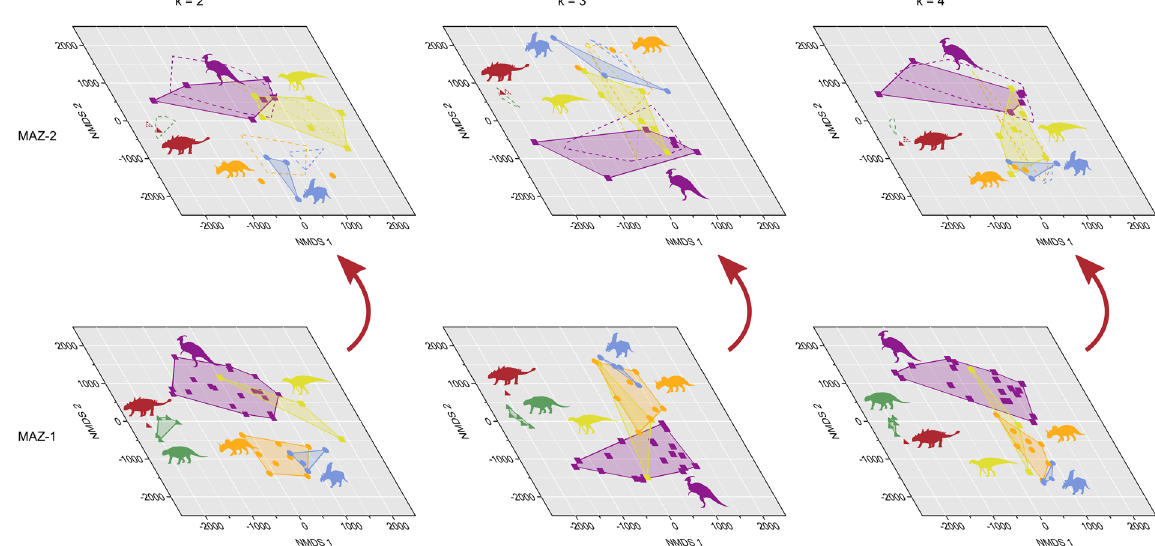
Figure 7. Time-constrained ecomorphospace comparisons between MAZ-1 and -2 for different values of k. Dashed lines in MAZ-2 ecomorphospaces indicate original taxon distribution in MAZ-1. Note that megaherbivore distribution in ecomorphospace varies little through time. Silhouettes not to scale. Colours after Fig.